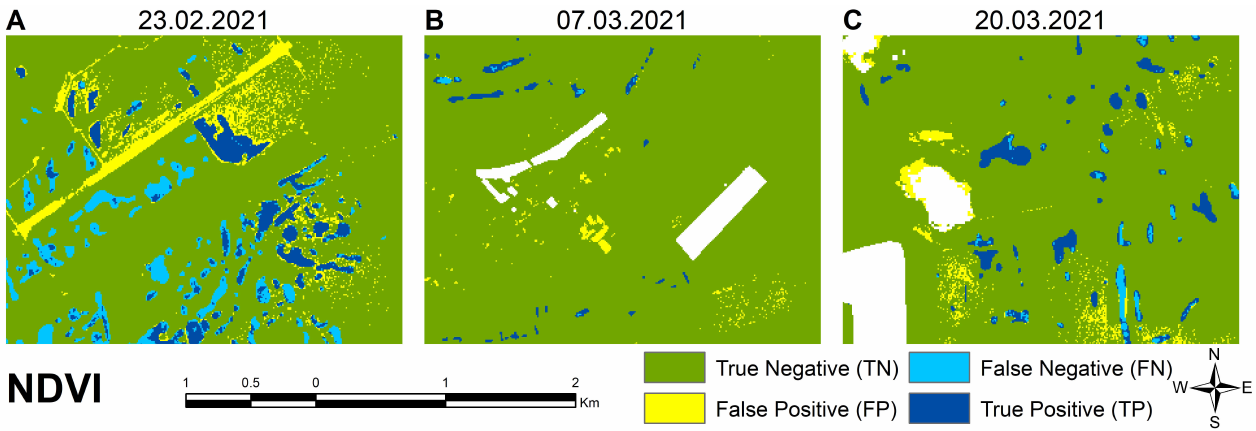
Figure 9. Examples of classification errors of the NDVI model on different dates, including ( A ): run ‐ way of the airport 23 February 2021; ( B ): scattered buildings and roads. The white areas are the masked ‐ out permanent water bodies 7 March 2021; and ( C ): errors due to cloud/shadow mask, 20 March 2021.